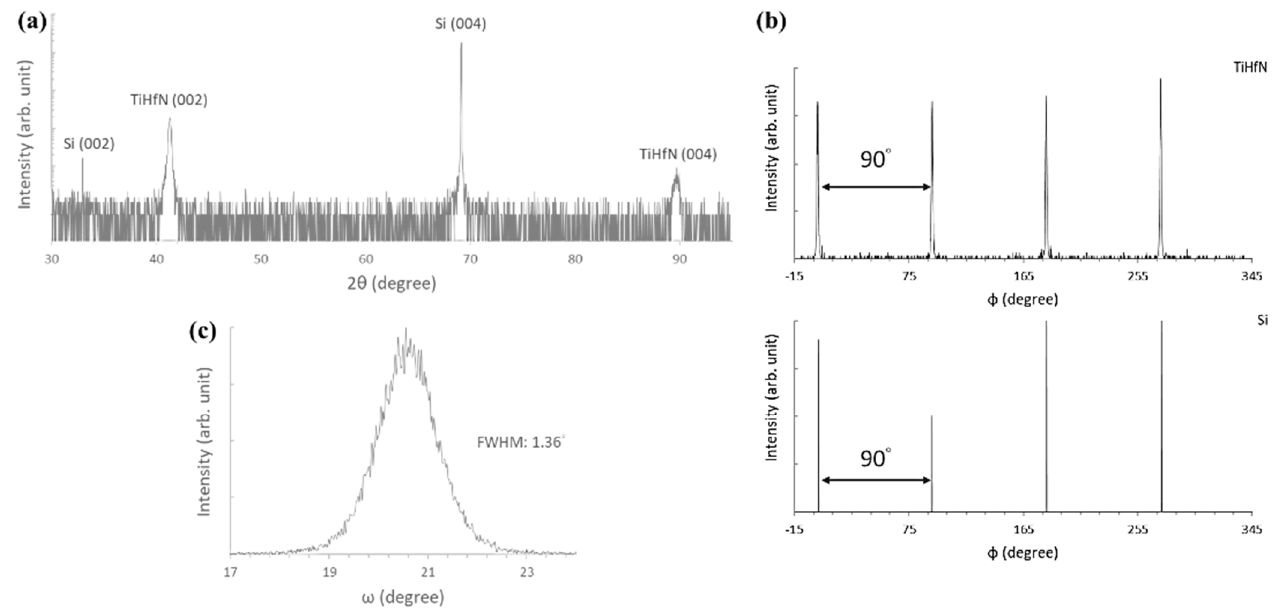
Figure 1. XRD analyses of the as-deposited TiHfN/Si sample. ( a ) 2 θ−ω pattern, ( b ) ϕ− scan